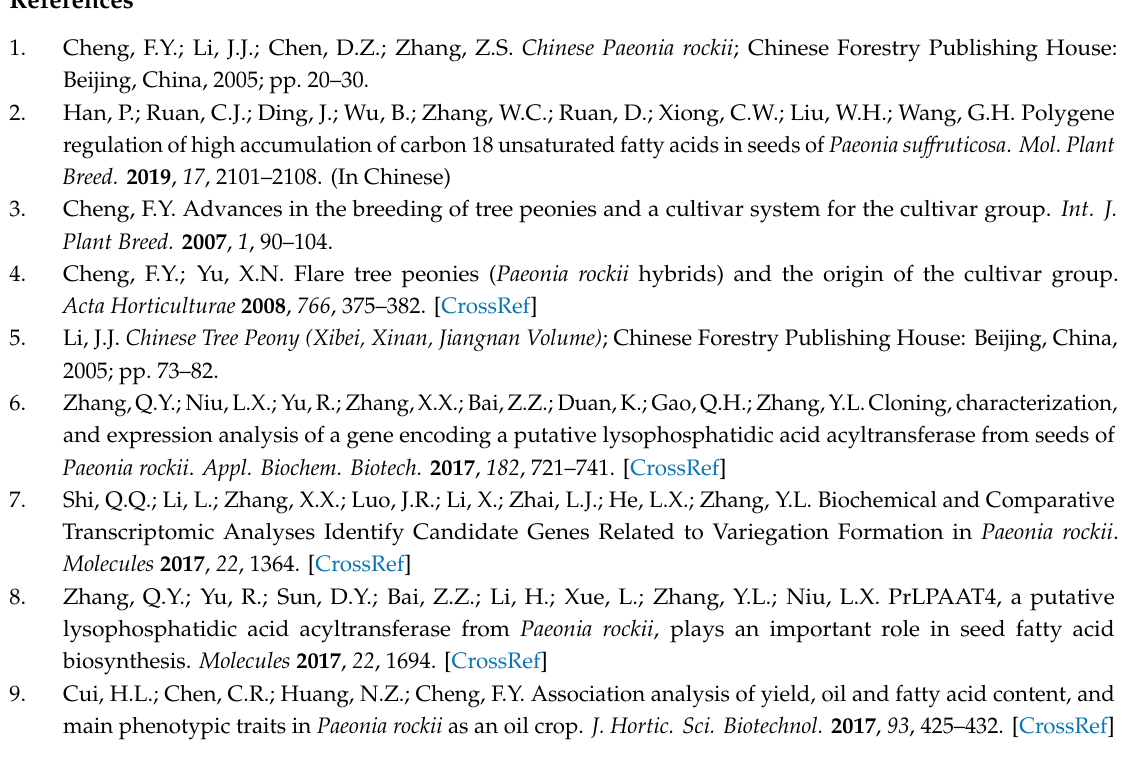
Table S1: The numbers, names, flower colors and grouping results of 282